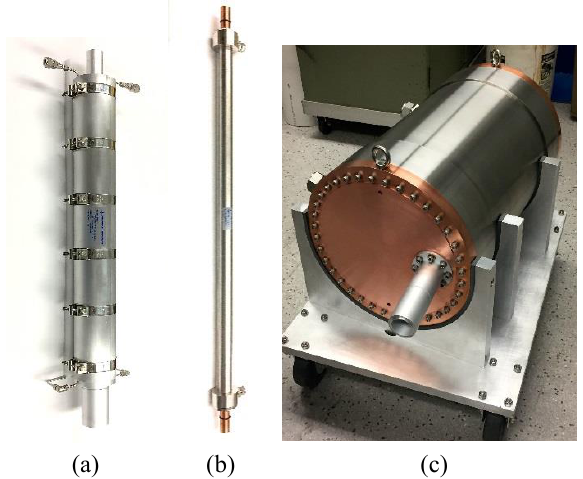
Fig. 6. The downtaper (a), attenuator (b), and tank (c) elements of the dummy load system designed for ITER conditions.